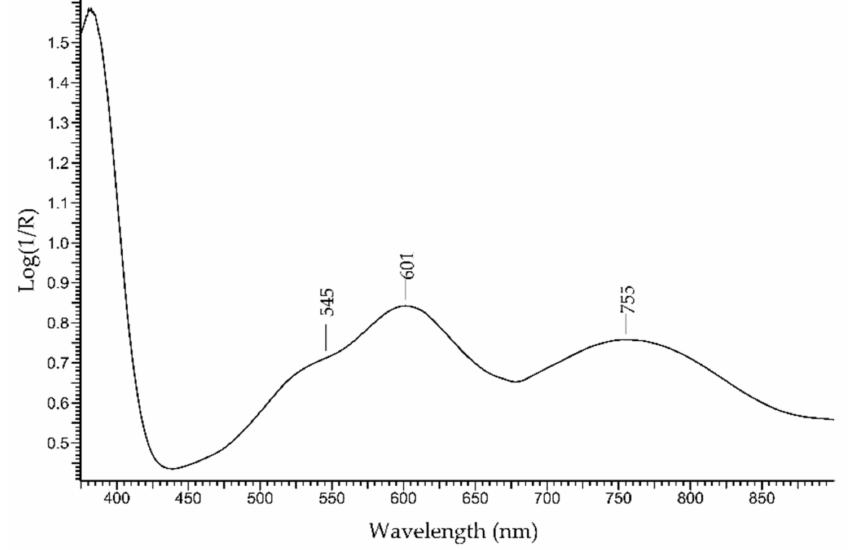
Figure 14. FORS spectrum in Log(1/R) coordinates of